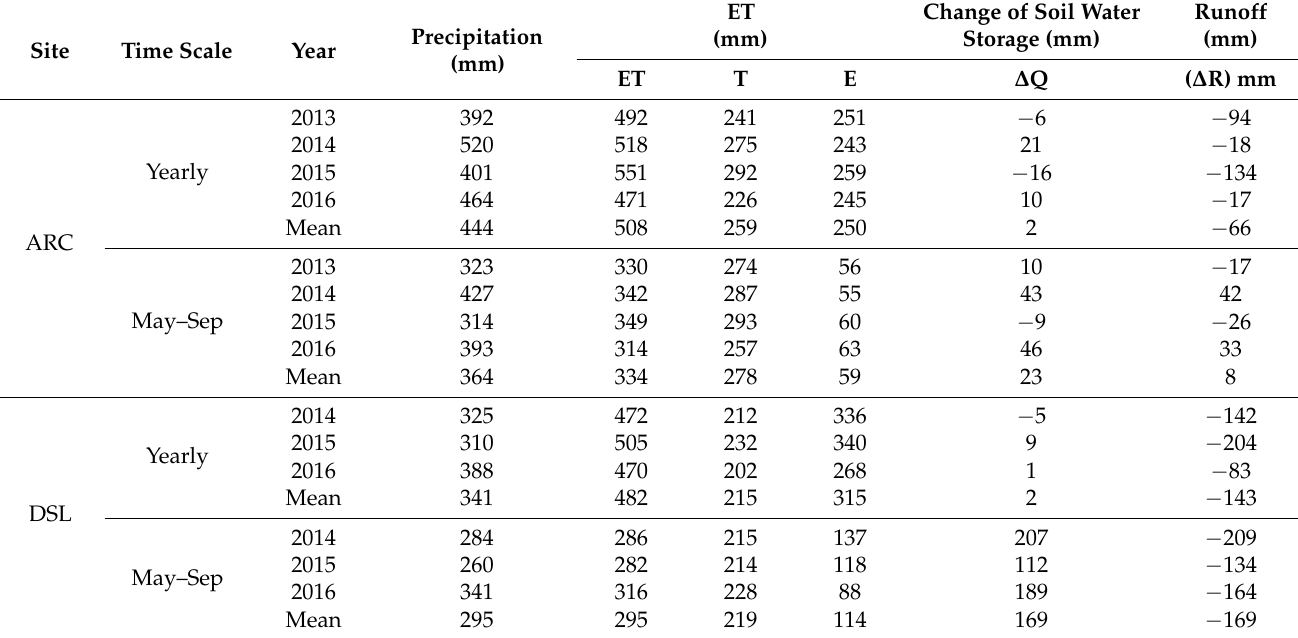
Table 2. Components of the water budget in the alpine meadow ecosystem of the upper